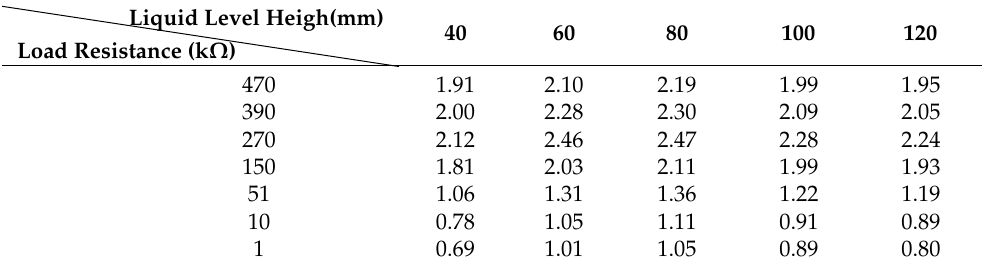
Table 2. Power of the piezoelectric transducer under different conditions.